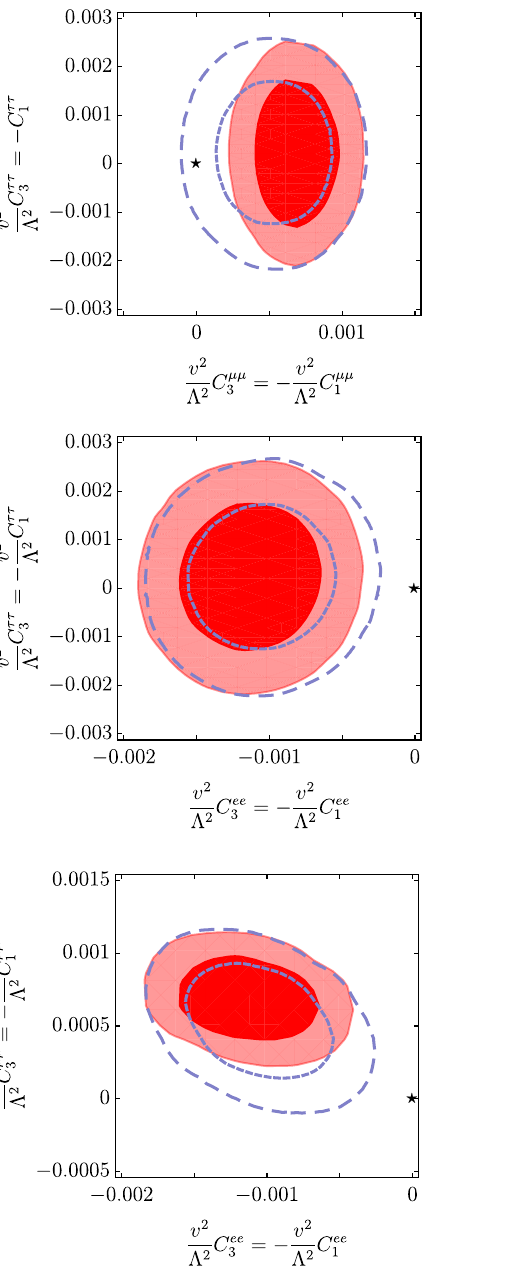
= − C (3) (left) and C (3) only (right). Like φ‘ φ‘ φ‘